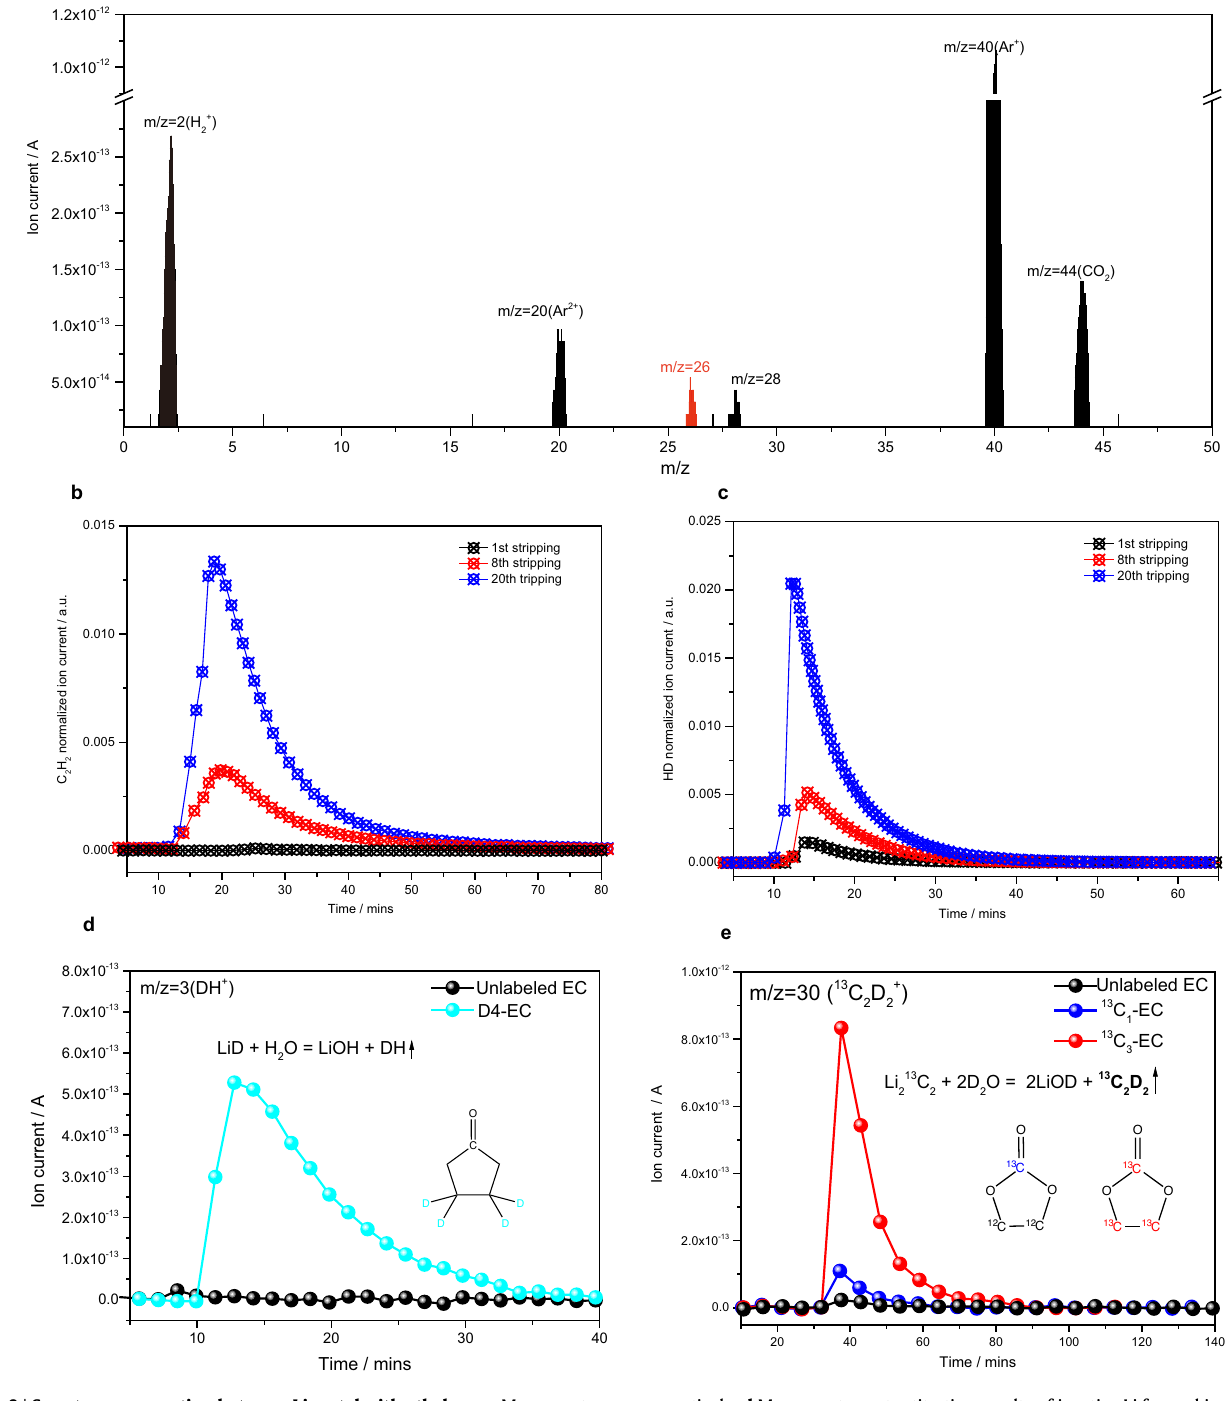
respectively. d Mass spectrometry titration results of inactive Li formed in unla- beled EC and in all deuterated EC (D 4 -EC). e Mass spectrometry titration results of inactive Li formed in unlabeled EC, carbonyl carbon labelled EC ( 13 C 1 -EC), and all carbon labelled EC ( 13 C 3